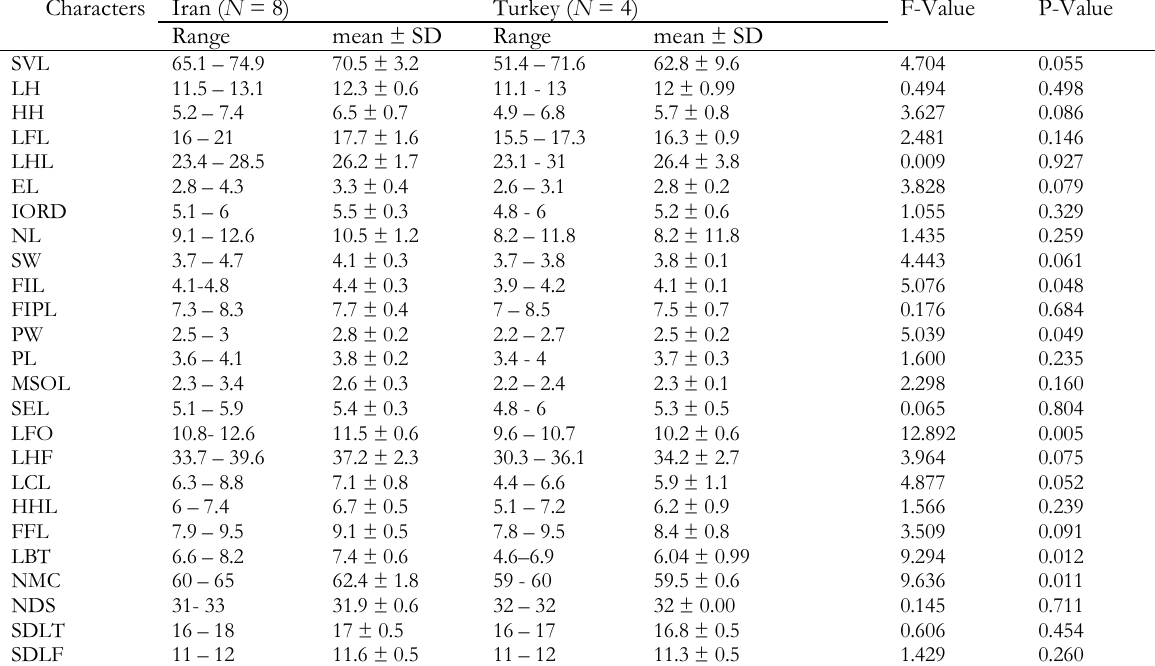
T ABLE 2. Results of One Way ANOVA (LSD-Test) and Independent sample t -test for measured characters of male specimens in two studied populations of T. vittata . Ranges, Mean ± Standard Deviation